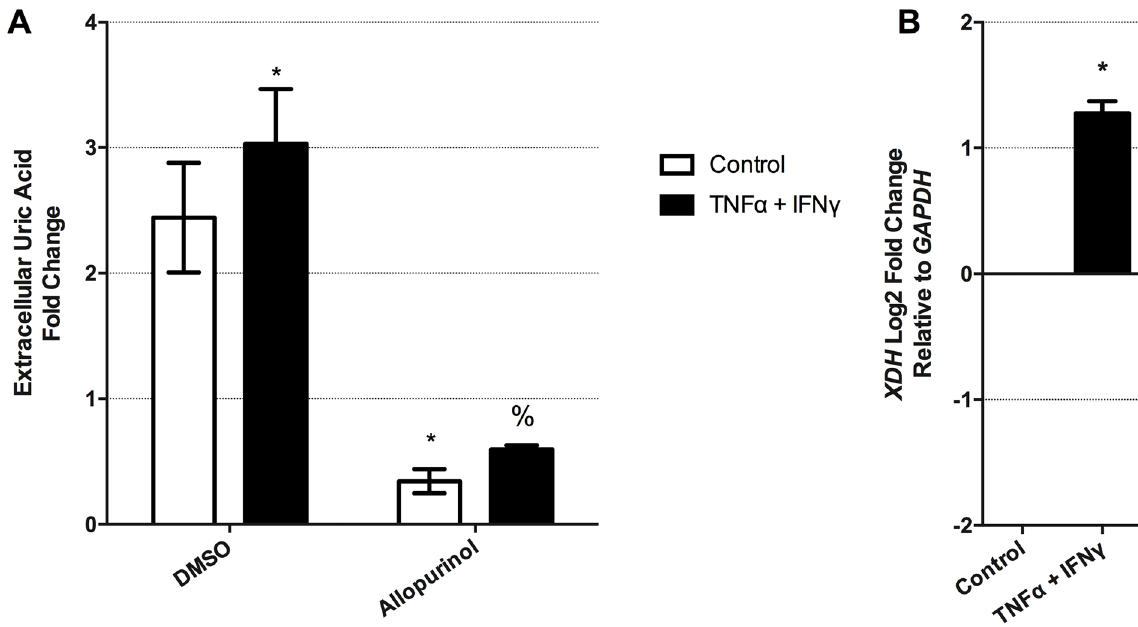
Fig 5. TNF- α and IFN- γ elevate extracellular uric acid levels and XDH gene expression in human airway epithelial cells. (A) HBEC-6KT humanairway epithelialcells were treated with TNF- α (20ng/ml) and IFN- γ (1000U/ml)for 24h followedby analysisof cell culture supernatant for uric acid levels in the presenceor absenceof allopurinol (500 μ M) (B) XDH geneexpressionfollowingTNF- α (20ng/ml) and IFN- γ (1000U/ml)treatment for 24h. Data represent mean +/- SD, n = 3. Significance is represented by * = p < 0.05 relative to DMSO/control, % = p < 0.05relative to DMSO/ TNF- α +IFN- γ